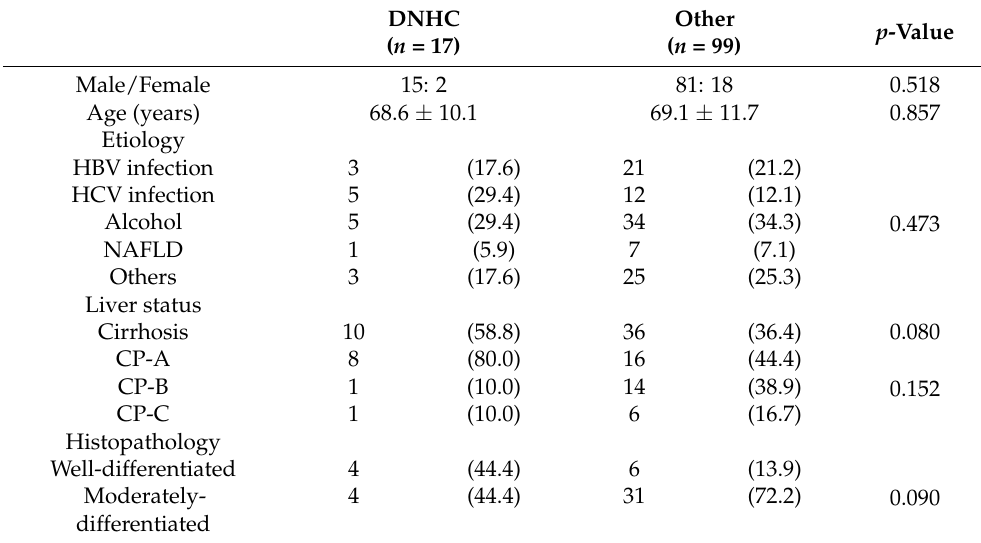
Table 3. Comparison between DNHC and the other groups in higher-stage